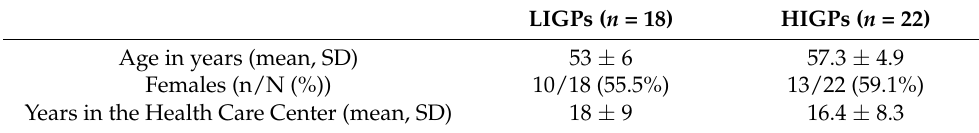
Table 1. Characteristics of participating GPs in the LIGPS and HIGPs